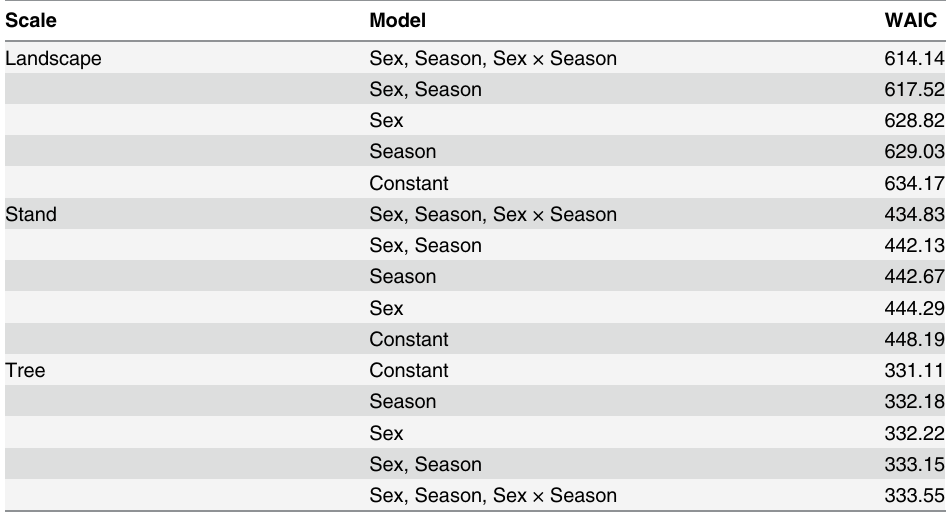
Table 3. Model selection results evaluating the evidence for sex- and season-specific differences in resource selection of Indiana Bat ( Myotis sodalis ) in Fort Drum, NY, USA between 2007 – 2011. Lower WAIC is